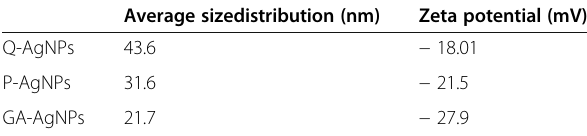
Table 1 Zeta potential and average size distribution of eco- friendly biosynthesized AgNPs